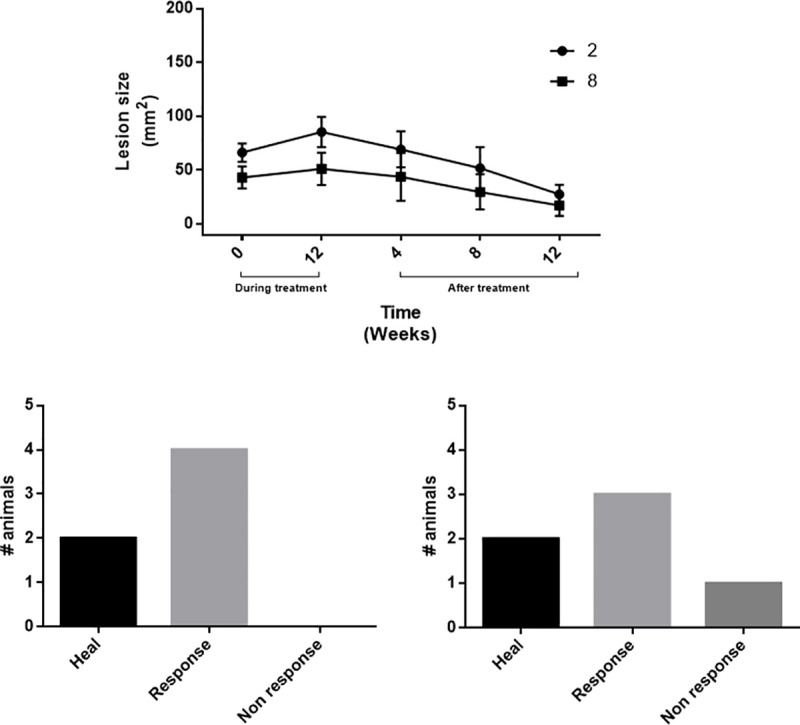
Effect of treatment with compounds 2 and 8 on hamsters suffering from CL.(a) Lesion size measurement (mm2) during treatment (pre- and posttreatment: weeks 4–12). Number of recovered hamsters showing improvement or lacking response to treatment with (b) compound 2 and (c) compound 8 (n = 6 for each treatment). CL, cutaneous leishmaniasis.